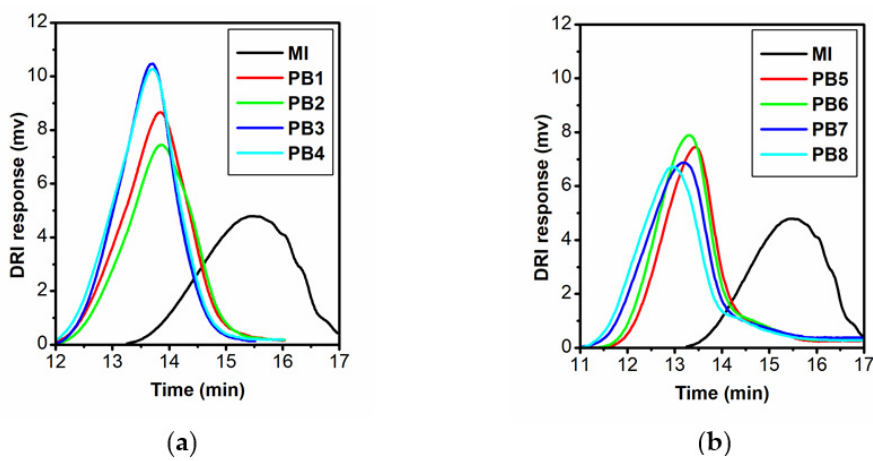
Figure 4. SEC/DRI chromatograms obtained for: ( a ) MI and PB1-PB4; ( b ) MI and PB5-PB8.